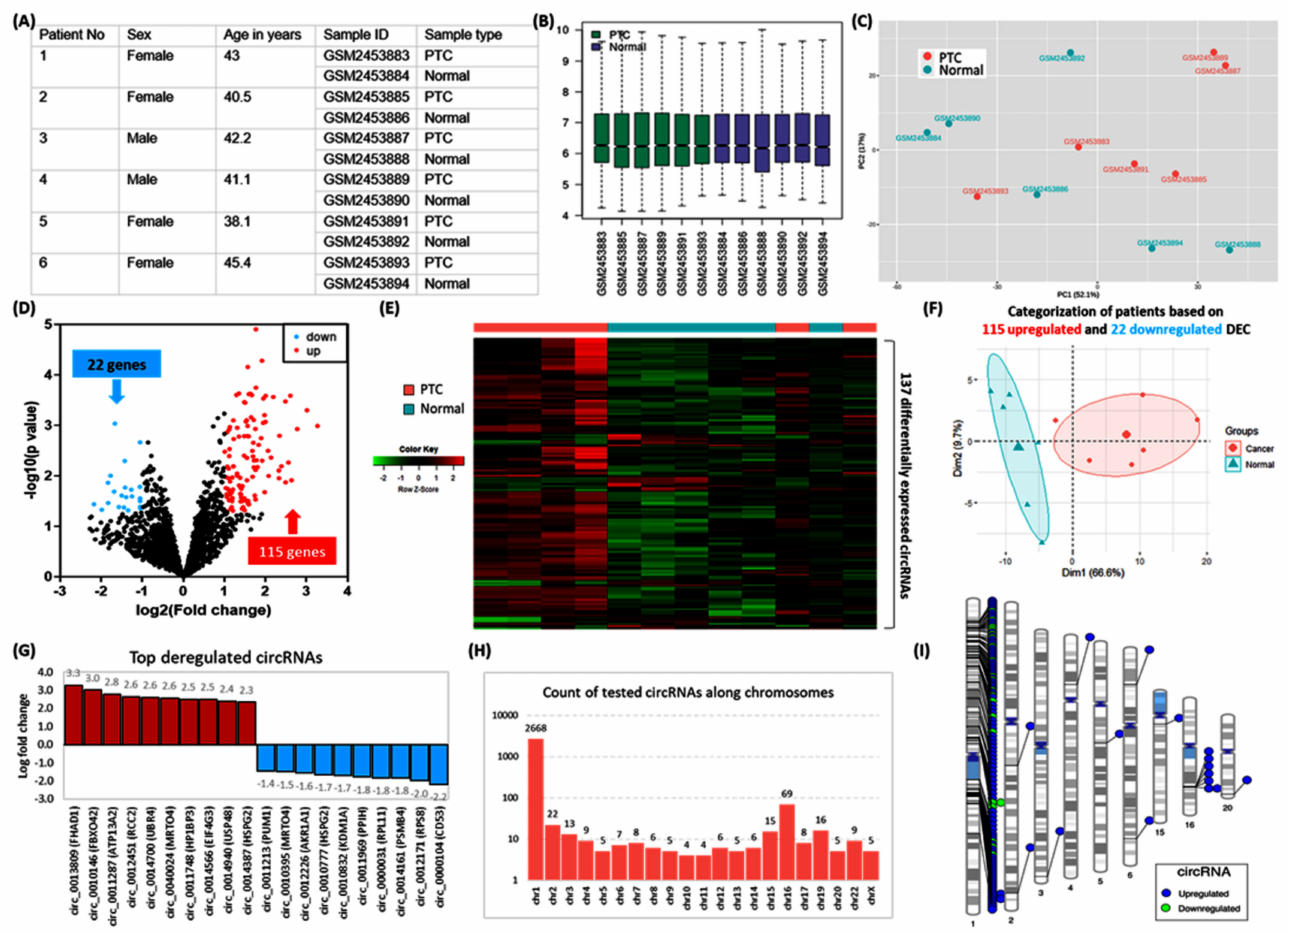
Figure 8. Microarray transcriptomic signature of circRNAs in human papillary thyroid carcinoma. ( A ) Characteristics of six PTC patients were retrieved from the Gene Expression Omnibus database (GSE93522). PTC was compared with their paired contralateral normal thyroid tissues ( B ) Boxplots showing the distribution of the values of the selected samples. Median-centered values are indicated after log transform and quantile normalization. ( C ) Principal component analysis for data exploration. The geometrical projection for samples is based on the similarities and differences in the expression of 2895 circRNAs. Samples are plotted across two coordinates; axis 1 explained 52.1% of the variance, whereas axis 2 demonstrated 17% of the data variability. ( D ) Volcano plot displays statistical signifi- cance ( − log10 p -value) versus magnitude of change (log2 fold change) in PTC compared with controls. Each dot represents a circRNA. The plot shows 137 significantly differentially expressed circRNAs (DEC): 115 upregulated (red dots) and 22 downregulated (blue dots). Analysis was performed using GEO2R software, with the p -value threshold at <0.05 and log fold changes (FC) at >1. ( E ) Heatmap for the 12 thyroid tissue specimens using the 137 differentially expressed circRNAs. There was an upregulation pattern of genes in patient samples. Clear differentiation of four PTC tissues and incomplete separation of two others are shown. ( F ) Principal component analysis to visualize how samples are related to each other. By using the deregulated genes, a complete demarcation was observed between PTC and normal tissues. Axes 1 and 2 explain 66.6% and 9.7% of the variability, respectively. ( G ) The top-up and downregulated circRNAs in PTC tissues. Derived protein-coding genes from which circRNAs were formed are shown. Fold change values are depicted at the end of the bars. ( H ) Frequency of tested circRNAs in the microarray according to their chromosomal localization. Y axis is log10 transformed, and the X axis represents the human chromosomes with removed missing chromosomes (chromosomes 18, 21, and Y). ( I ) Chromosomal ideograms represent the differentially expressed circRNAs annotated with lines in color at specific base-pair locations: blue for upregulated DECs and green for downregulated